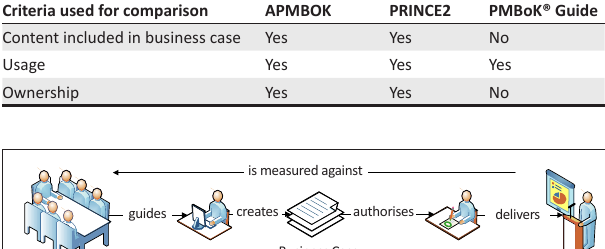
TABLE 1: Summary of business case from projec t management literature. Criteria used for comparison